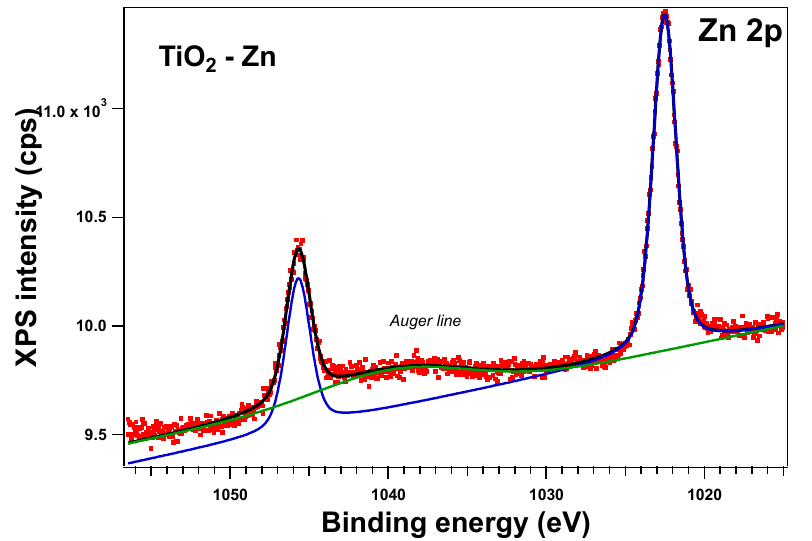
Figure 3. XPS spectra of the Zn 2p level of the as-prepared Zn-doped sample: red symbols for the experimental data, black line for the fit, blue line for C1, and green line for C2 (Auger line).